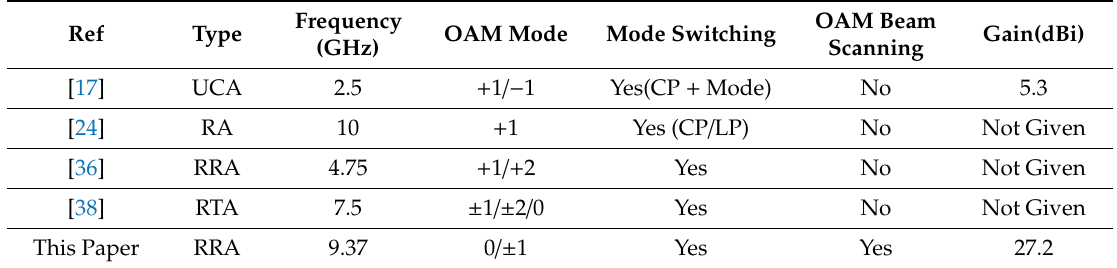
Table 2. Comparison with other published OAM